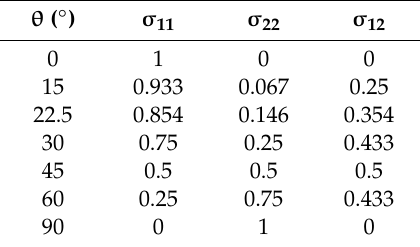
Table 1. Stress states in o ff -axis